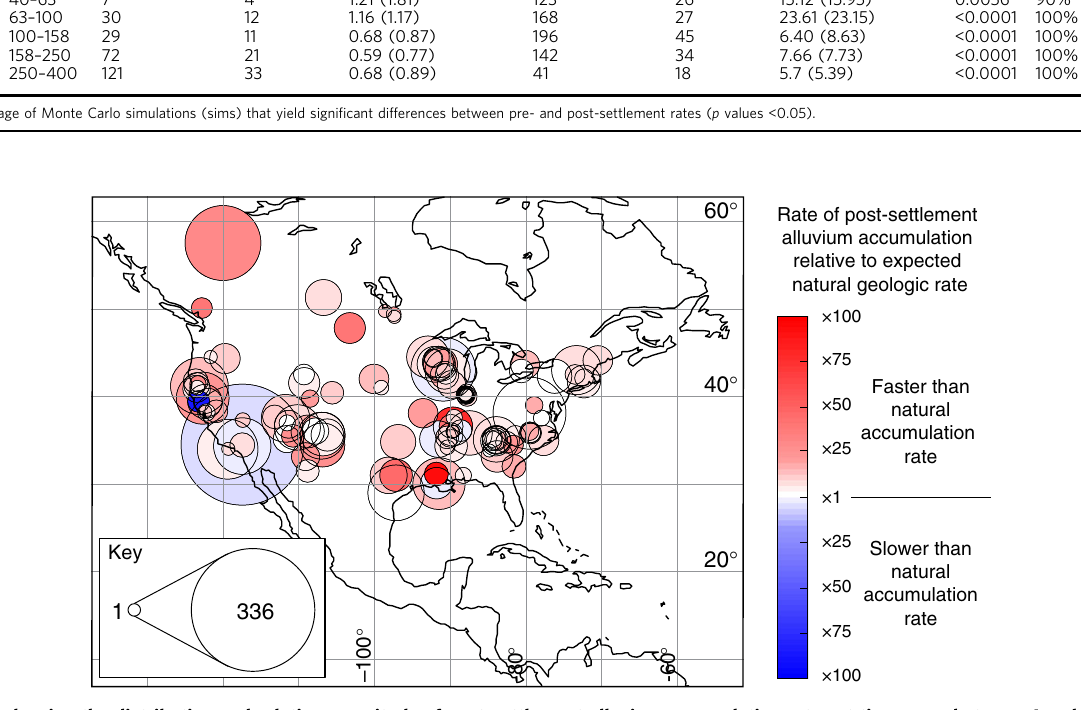
Fig. 5 Map showing the distribution and relative magnitude of post-settlement alluvium accumulation rates at timespans between 1 and 400 y. The data are sized according to the number of rates at each site. The color-coding quanti fi es by how much the median post-settlement rate at the site is faster or slower than the expected rate of natural geologic accumulation measured at the same timespan. The expected natural geologic rate at timespans between 1 and 400 y is de fi ned by the regression slope in Fig. 4. Note how most (94%) of post-settlement rates are faster than the expected natural rate, emphasizing the anthropogenic impact on alluvium accumulation. See main text for